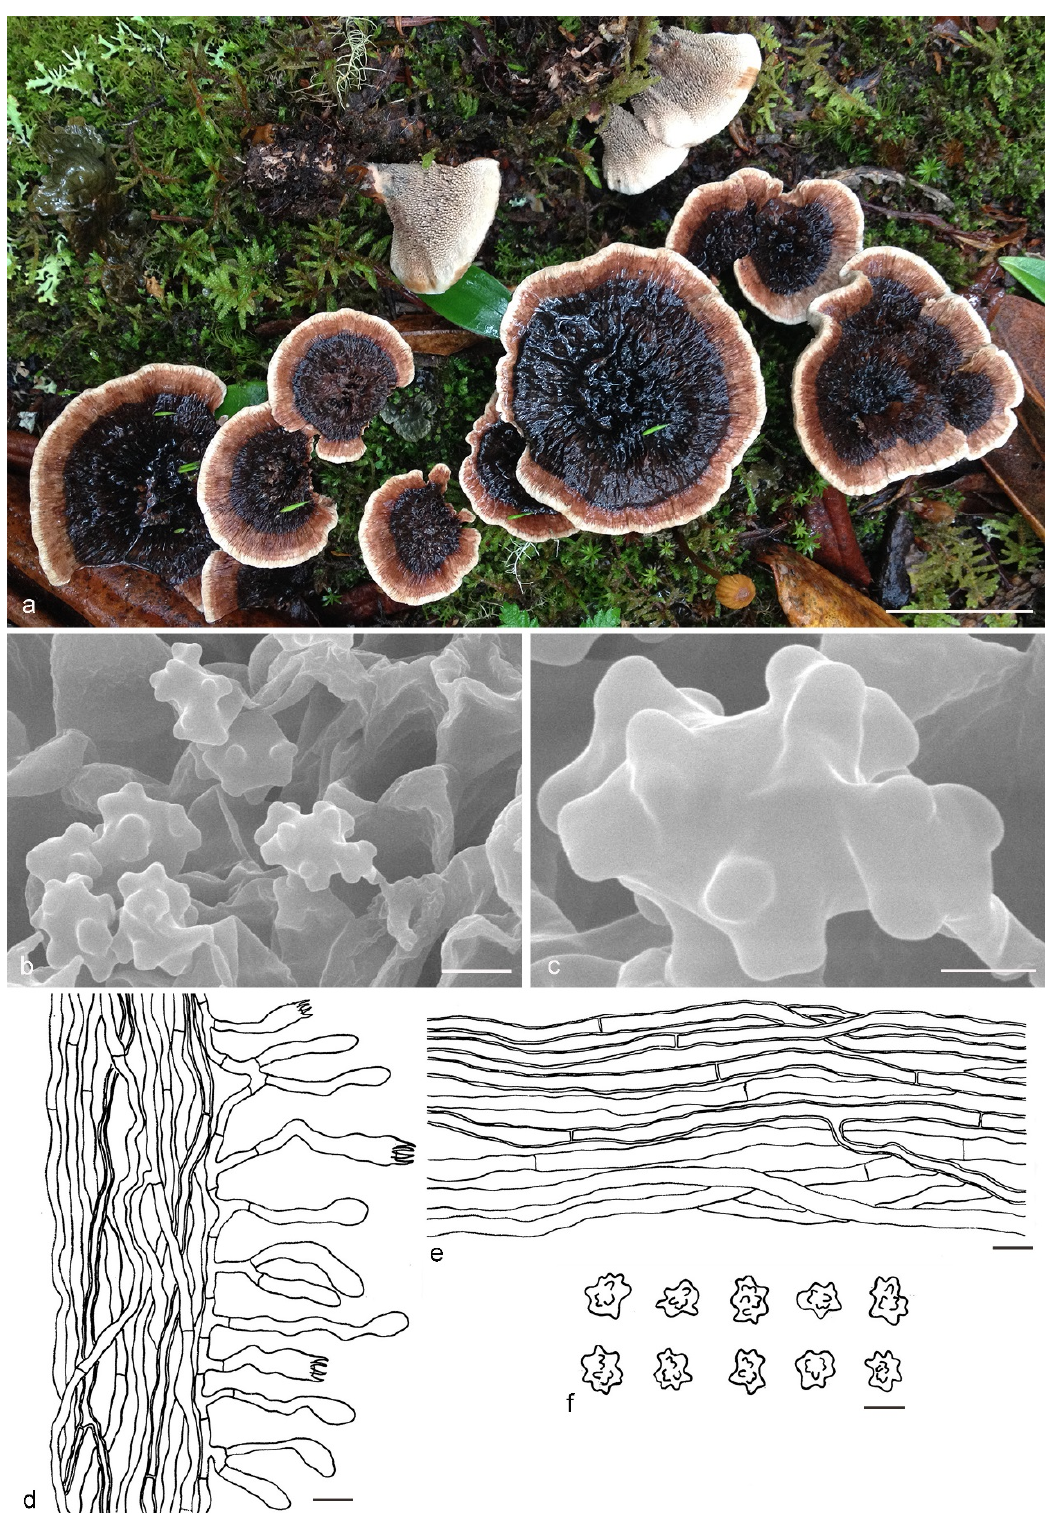
Figure 8. Hydnellum atrorubrum. ( a ): Basidiocarps; ( b , c ): SEM of basidiospores; ( d – f ): Microscopic structures (drawn from IFP 019377); ( d ): Section of hymenophore trama with basidia; ( e ): Hyphae from pileus context; ( f ): Basidiospores. —Scale bars: ( a ) = 2.5 cm; ( b ) = 3 μm; ( c ) = 1 μm; ( d , e ) = 10 μm; ( f ) = 5 μm. Hydnellum bomiense Y.H. Mu & H.S. Yuan, sp. nov. (Figure 9) MycoBank MB839035